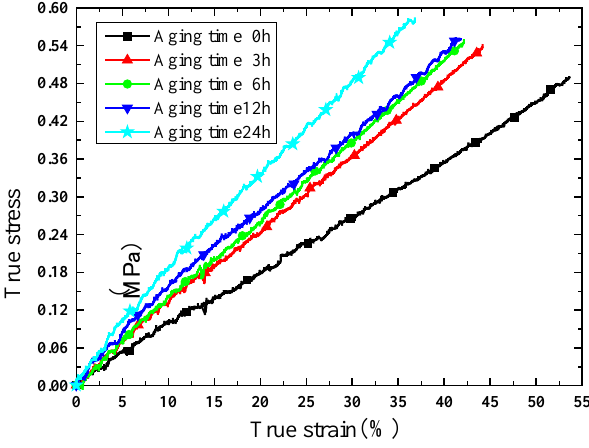
Figure 10. True strain versus stress curves at different aging times (strain rate: 8 × 10 − 4 /s, mass fraction: 0%).